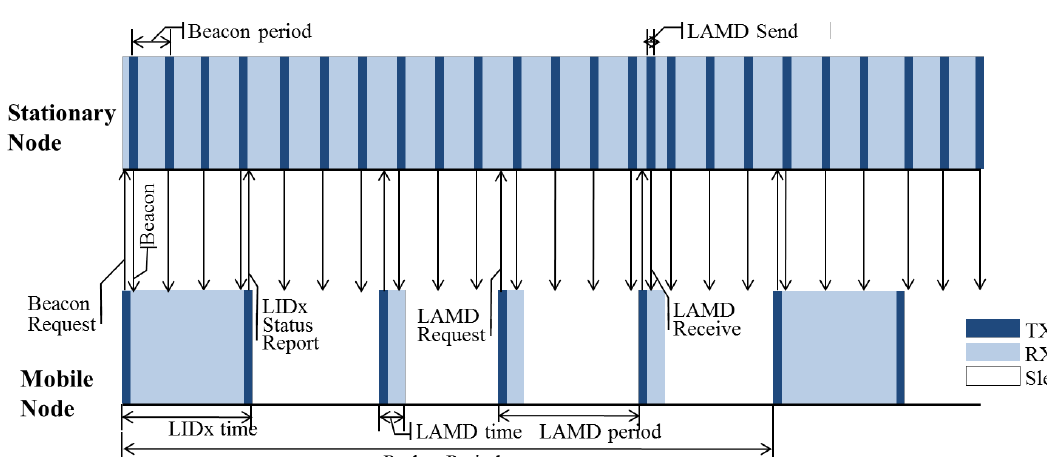
Figure 5. LIDx and LAMD